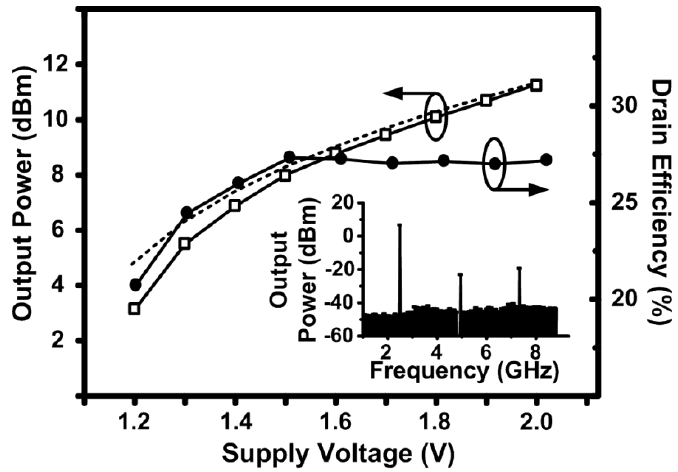
Figure 8. Measured output power and drain efficiency of the 2.4 GHz design as a function of the supply voltage. The dashed line shows the simulated output power and the inset figure shows the measured spectrum of the output signal at a supply voltage of 1.5